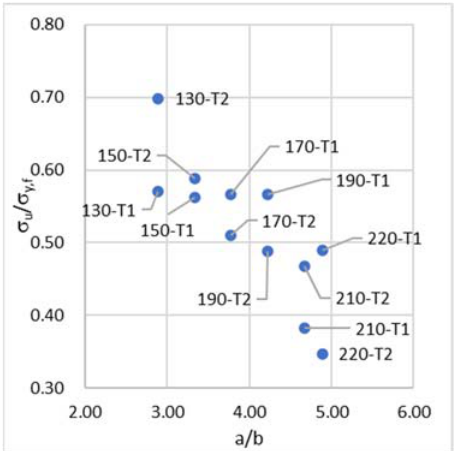
Figure 9. Ultimate strength as a function of the length ‐ to ‐ breadth ratio.